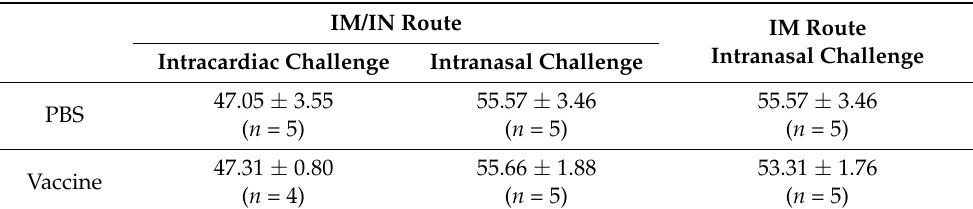
Table 2. The total average percentage of nicotine recovered from the brain, sera, lung, and heart of each challenge group ± SEM.